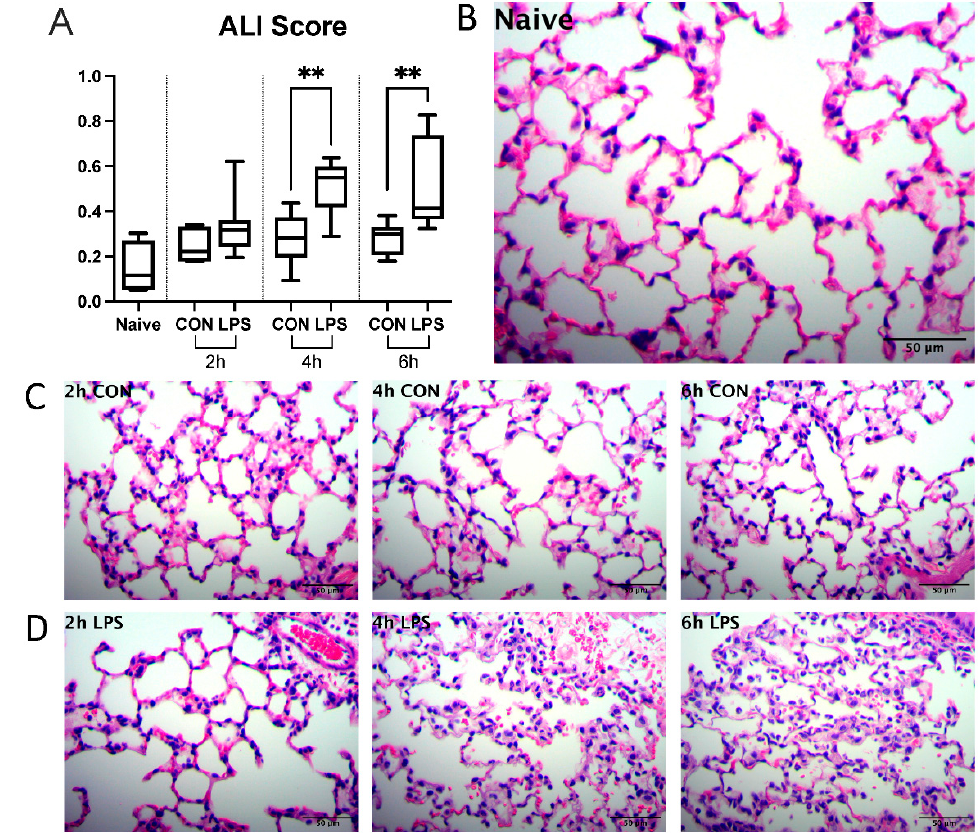
Figure 1. Intranasal administration of LPS from P. aeruginosa induces ALI at 4, 6 h post-induction. ( A ) Histopathological lung scores. ( B ) Representative fields of view (FOV) from naïve group. ( C ) Representative FOV from control (CON) group at 2, 4, and 6 h timepoints. ( D ) Representative FOV from LPS group at 2, 4, and 6 h timepoints. Whiskers show minimum and maximum values, boxes represent 25–75% data ranges, and horizontal lines within boxes represent medians. Statistically significant differences were determined via Mann–Whitney tests between LPS and control groups at each timepoint and are depicted as ** p ≤ 0.01.